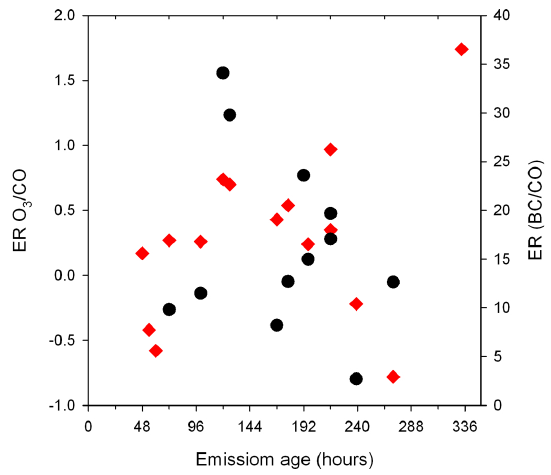
Fig. 5. ERs of O 3 (red) and BC (black) relative to CO observed for the 16BB events detected at CMN by